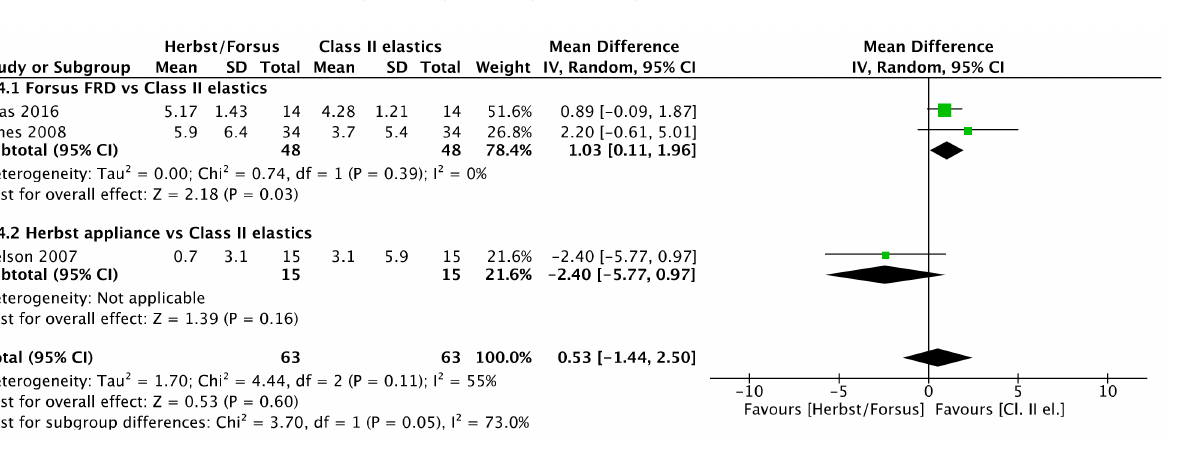
Figure 5. Forest plot of the lower incisor inclination changes using the random effects model